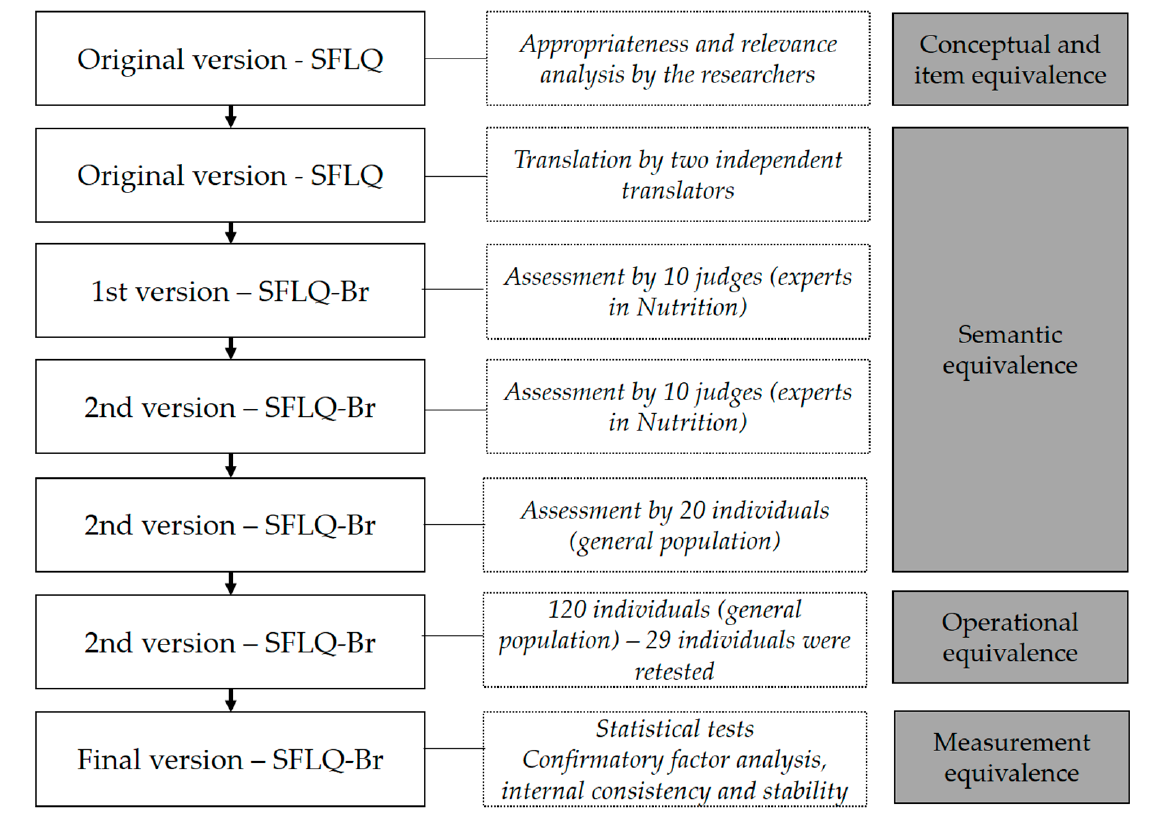
Figure 1. Study flow, including the sample and process of each step.